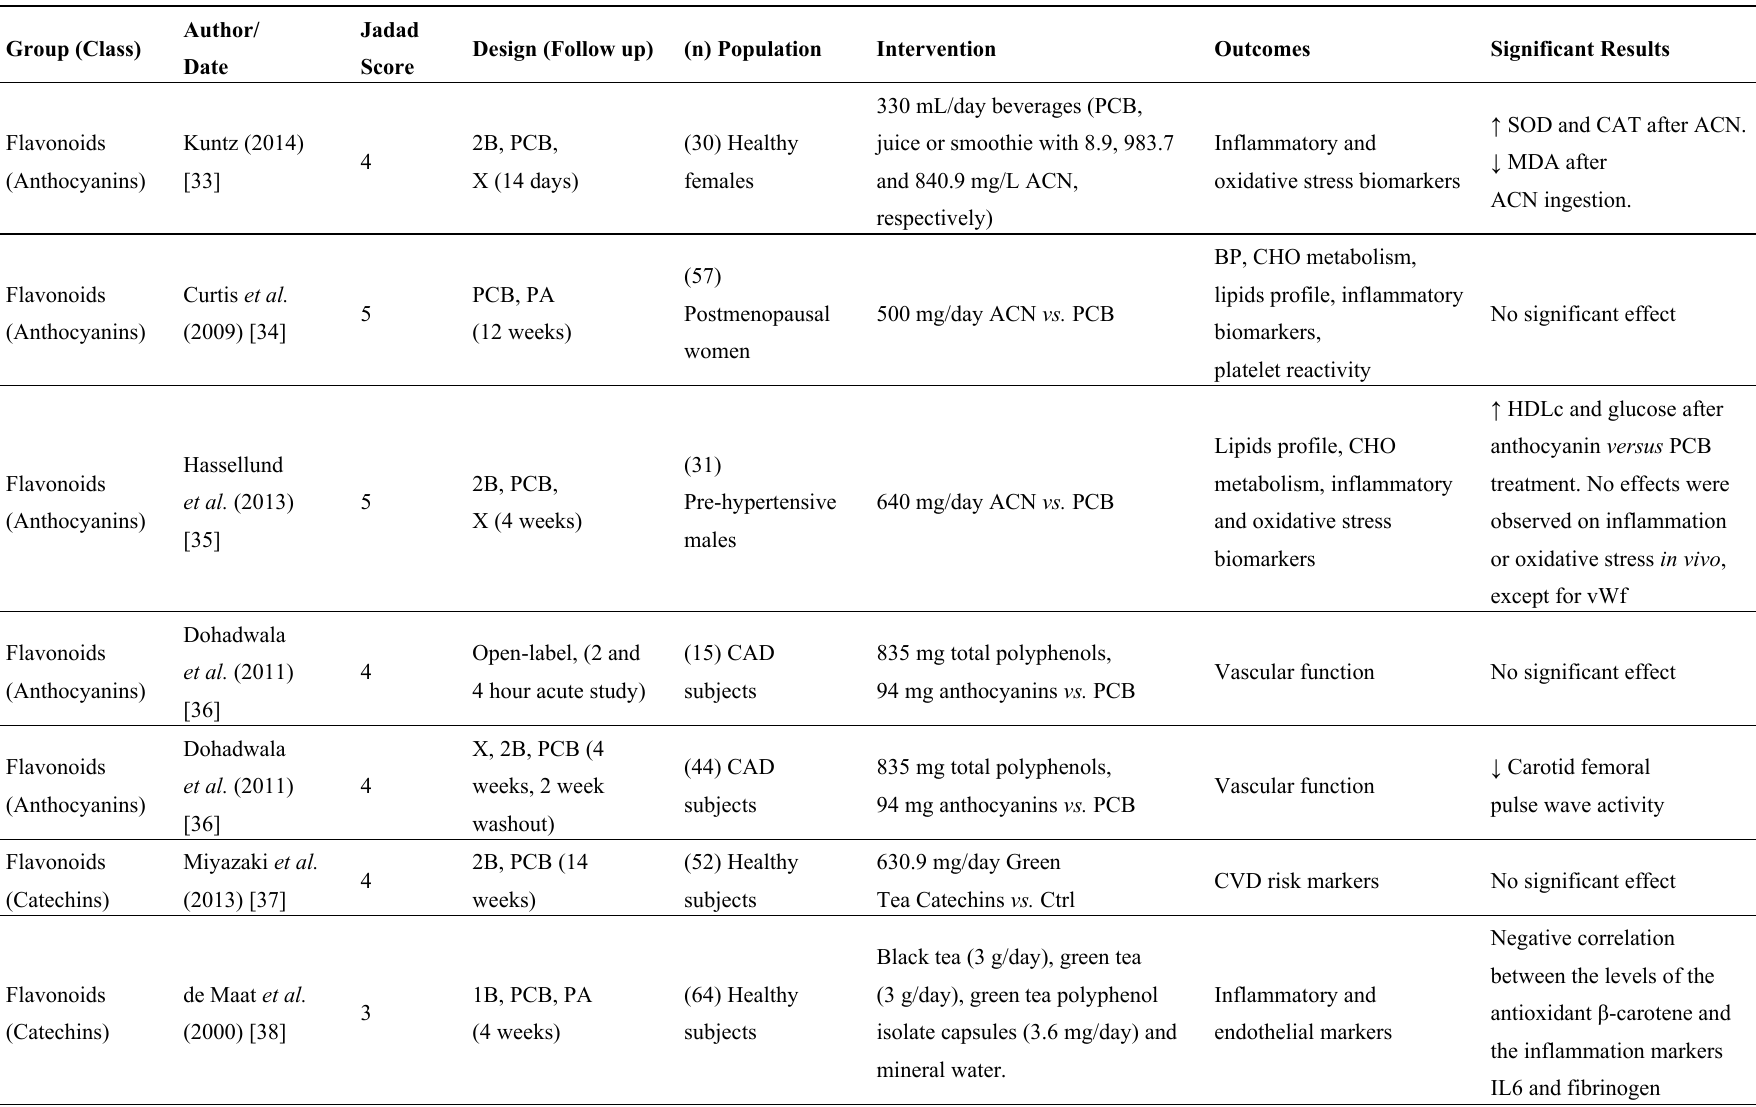
Table 2. RCTs of polyphenols (anthocyanins, catechins, flavanols and flavonols) in CVD